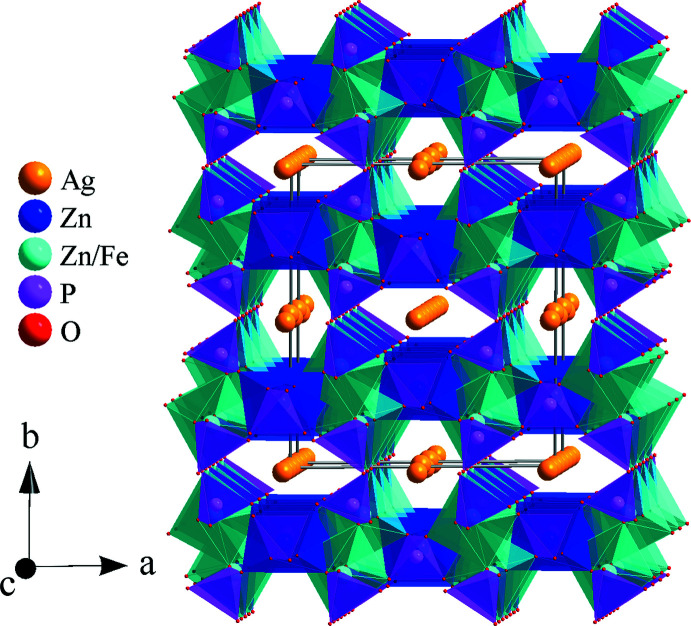
Perspective view of the crystal structure of Ag1.64Zn1.64Fe1.34(PO4)3, showing the channels running along the [001] direction in which the Ag+ are located.